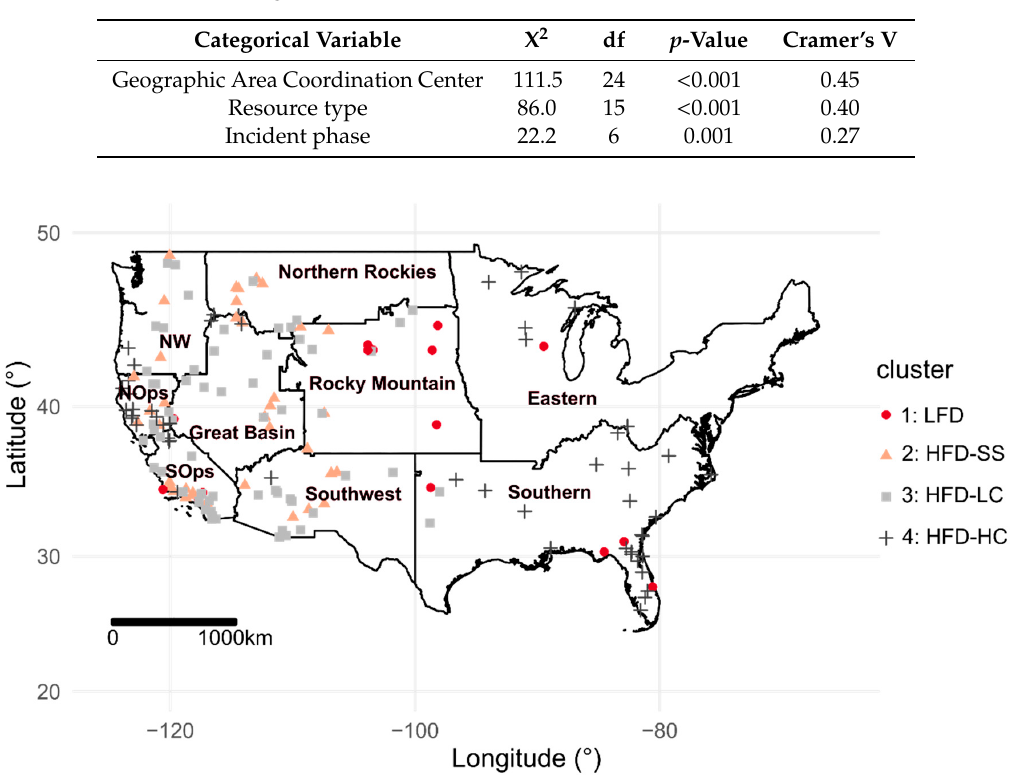
Figure 7. Locations of 166 US wildland firefighter entrapments (1981–2017) by cluster type and Geographic Area Coordination Center (GACC). The abbreviated GACCs include the Northwest (NW), North Ops (NOps), and South Ops (SOps).